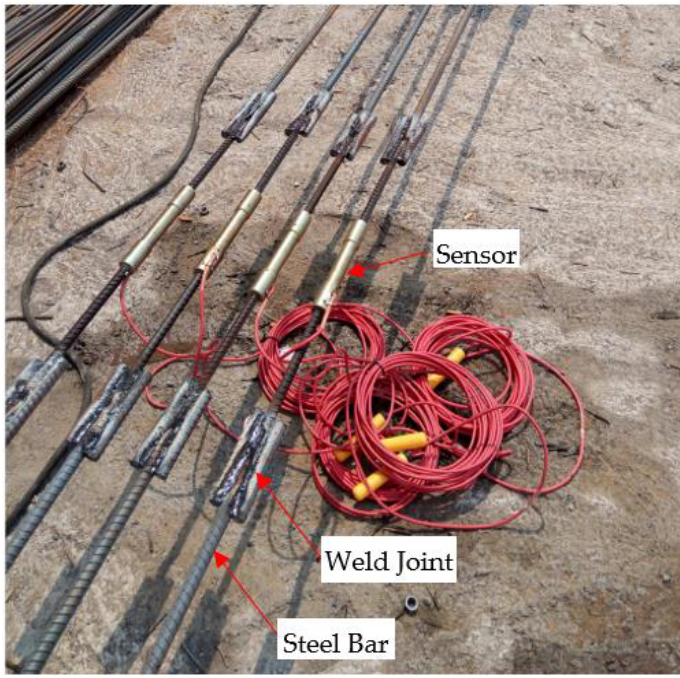
Figure 4. The manufactured testing soil nails.